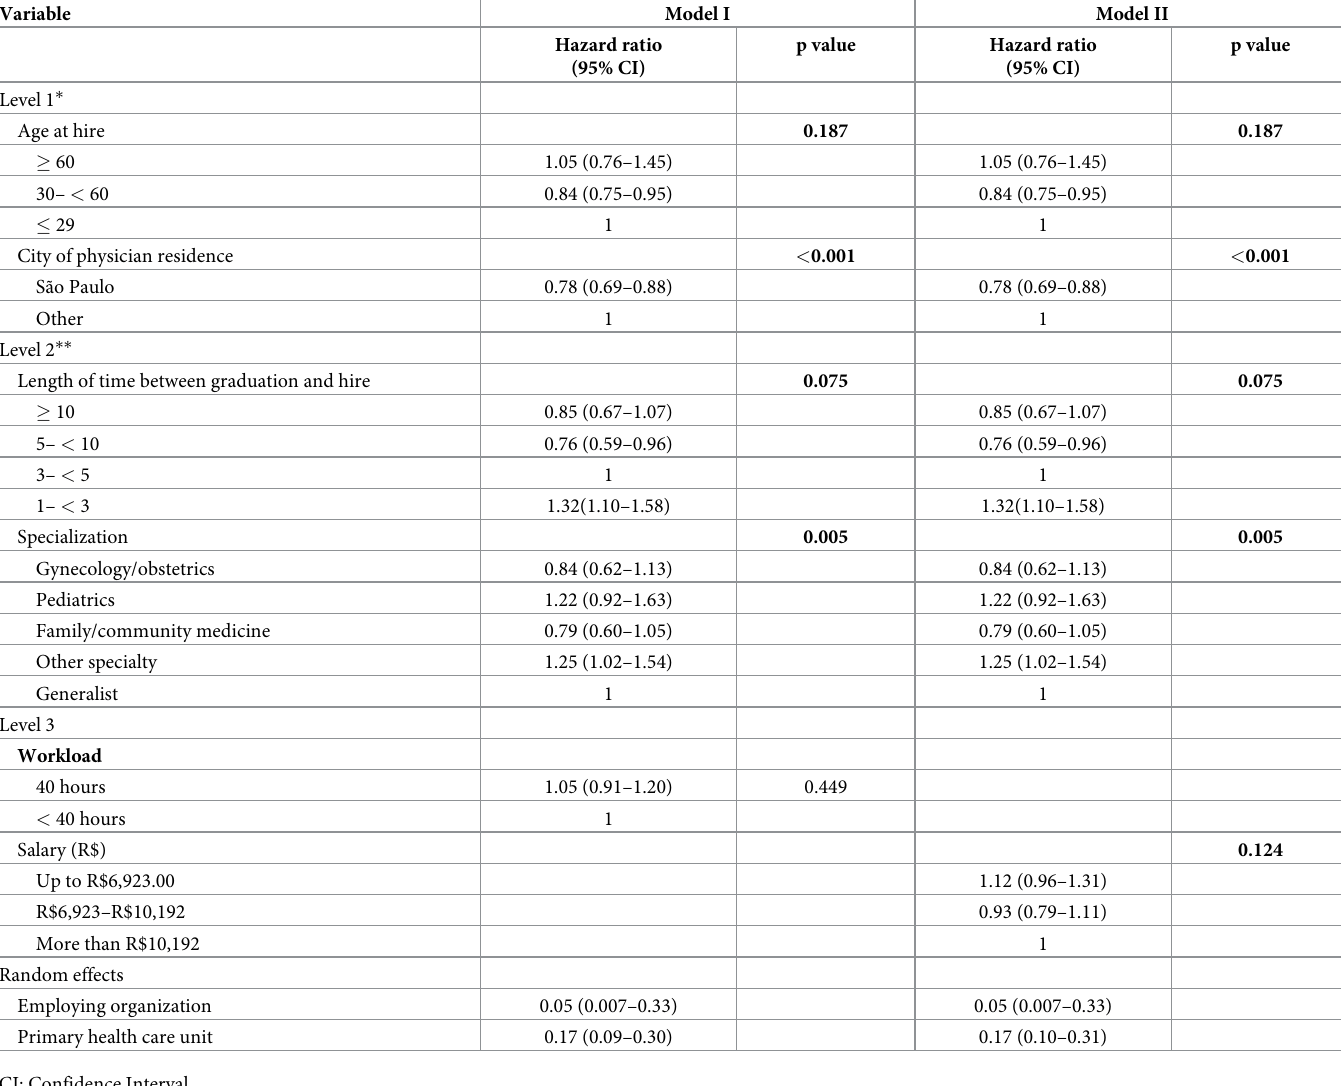
Table 3. Adjusted analysis for sociodemographic characteristics, qualifications, and professional experience associated with physician termination from PHC (n =